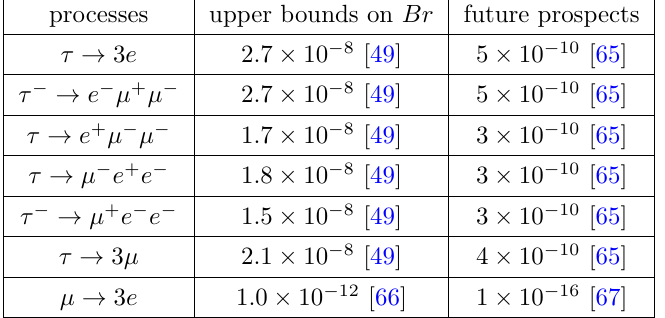
Table 5 . Summary of the upper bounds on the branching ratios ( Br ) of the LFV decays at 90 % CL. The future prospects for the LFV processes are also shown on the last